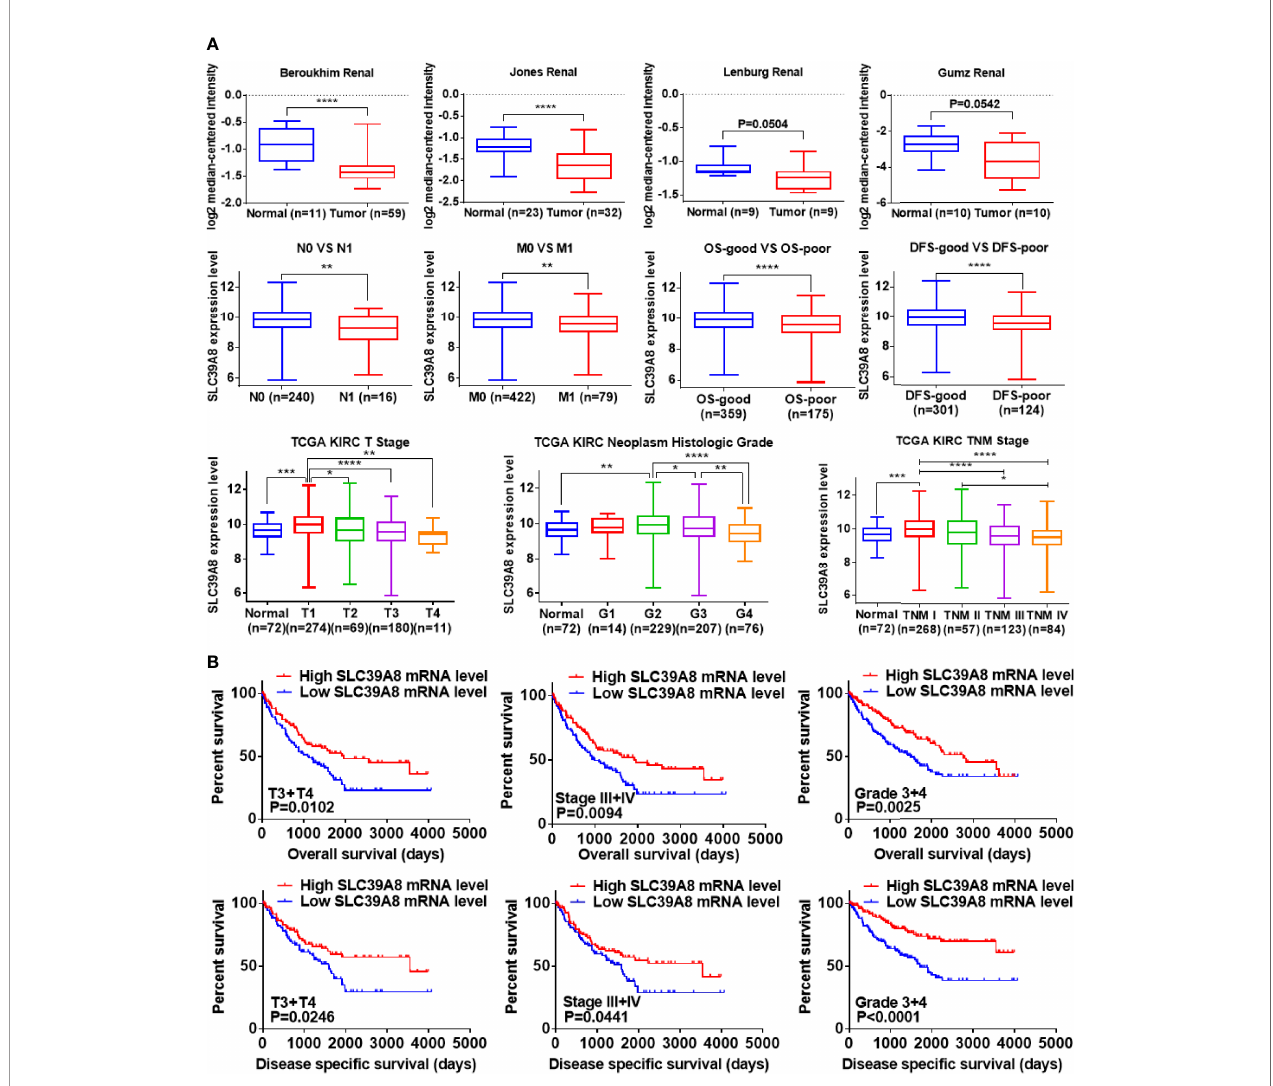
FIGURE 3 | SLC39A8 was down expression and positively associated with tumor progression and worse prognosis in ccRCC patients. (A) ONCOMINE database analysis showed that the mRNA expression levels of SLC39A8 were down-regulated in ccRCC in statistics by Beroukhim et al. (45) and Jones et al. (46), but similar in two studies of Lenburg et al. (47) and Gumz et al. (48). In addition, data analysis based on TCGA showed that with the progression of tumor, the expression of SLC39A8 decreased progressively. (B) Survival curve analysis determined that low SLC39A8 expression exhibits a shorter OS and DSS time in progressive ccRCC patients (T3 + T4, Stage III + IV, Grade 3 + 4). OS, overall survival; DSS, disease speci fi c survival. *P <0.05, **P <0.01, ***P <0.001, ****P